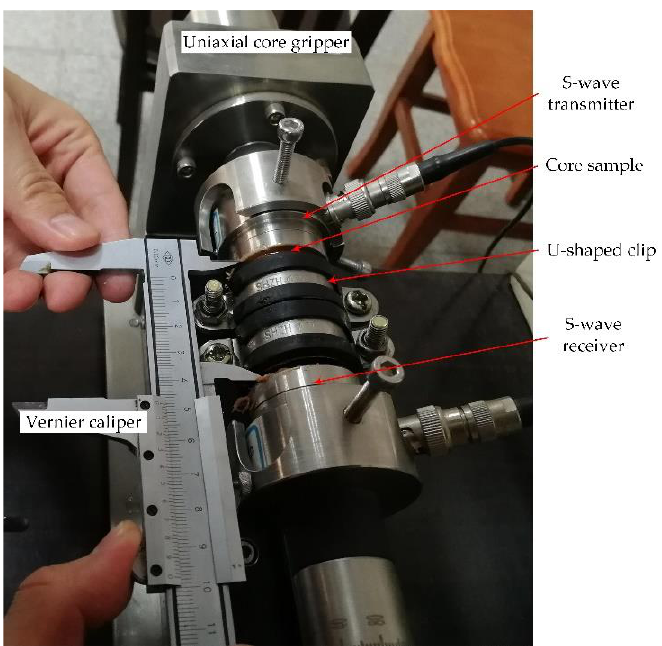
Figure 7. Photograph of the bidirectional clamped core with oblique fracture.